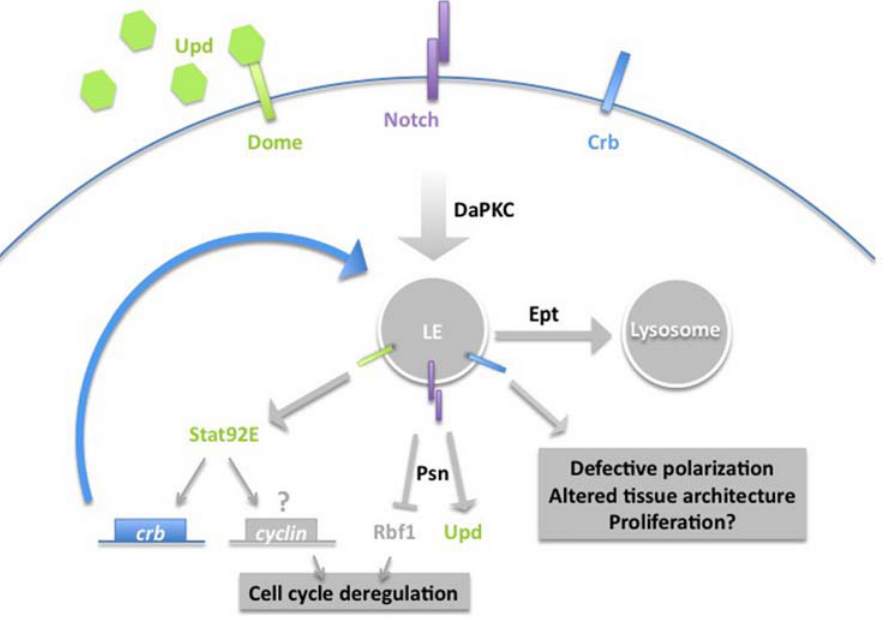
Figure 7. A hypothetical model of the cell-autonomous effects of ept loss. This model incorporates data from this paper and an accompanying study on the link between ept , DaPKC, Notch, Crb, Psn and Rbf1. The Erupted protein (Ept) is required to traffic Crb (blue), Notch (purple), and Dome (green) into the lysosome. DaPKC may regulate an upstream step in this process by promoting internalization of Notch and Crb. Loss of Ept causes Notch, Crb, and Dome (and perhaps other unidentified receptors) to accumulate in the endosome, from which they drive downstream effects. Stat92E likely has many nuclear targets in ept mutant cells, including crb . Given the links between mammalian Stats and G1 cyclin expression, Stat92E may have the potential to affect expression of a cyclin as well. Presenilin (Psn) acts upstream of Rbf1, perhaps via its role in activating Notch; a similar role for Psn upstream of the Notch-target Upd is untested but would follow logically from the available data. The excess Crb expressed in ept mutant cells is predicted to cycle back into the late endosome (LE), leading to very high levels of vesicular Crb. Overexpressed Crb is known to disrupt tissue architecture (e.g. [30]) and may to do the same in the context of ept tumors.